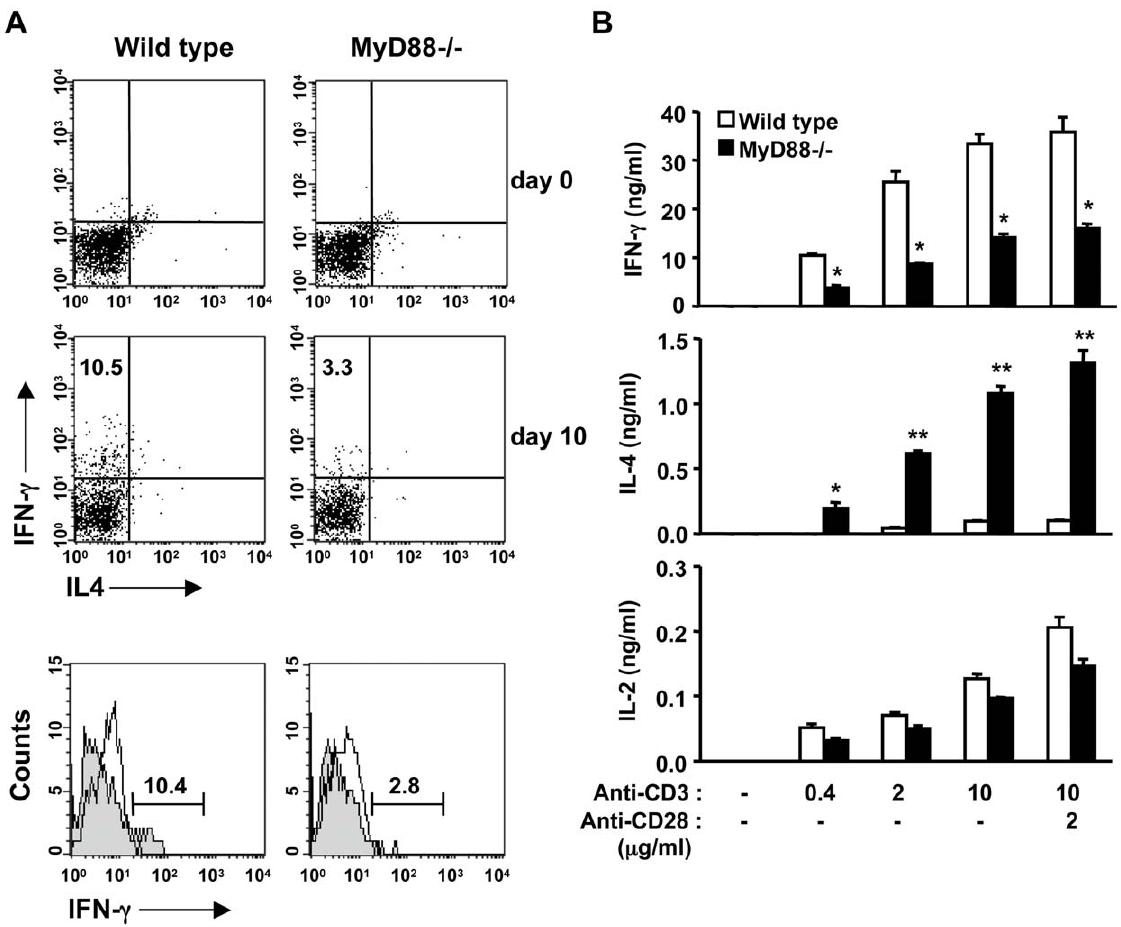
Figure 3. MyD88-deficient mice had reduced Th1 immune responses during E.muris infection. (A) The number of IFN- c producing CD4 + T cells decreased in infected MyD88-deficient mice. Mice were infected with E. muris for 10 days. Total splenocytes were gated for CD4 surface expression, and the expression of intracellular IFN- c and IL-4 was analyzed by flow cytometry (upper panel). Flow cytometric analysis of intracellular IFN- c expression in splenic CD4 + T cells from uninfected (open histograms) or infected (shaded histograms) mice (lower panel). Numbers in top left quadrants indicate the percentage of IFN- c producing cells in the gated CD4 + T cells. (B) Production of IFN- c , IL-4, and IL-2 from splenic CD4 + T cells was analyzed by ELISA after restimulation with plate-bound anti-CD3 and anti-CD28 antibodies at the indicated concentrations. Error bars represent SD of triplicate samples. The P -values were determined by Student’s t -test (Wild type vs. MyD88-/-). * P , 0.05. ** P , 0.01. Data are representative of at least three independent experiments in A and